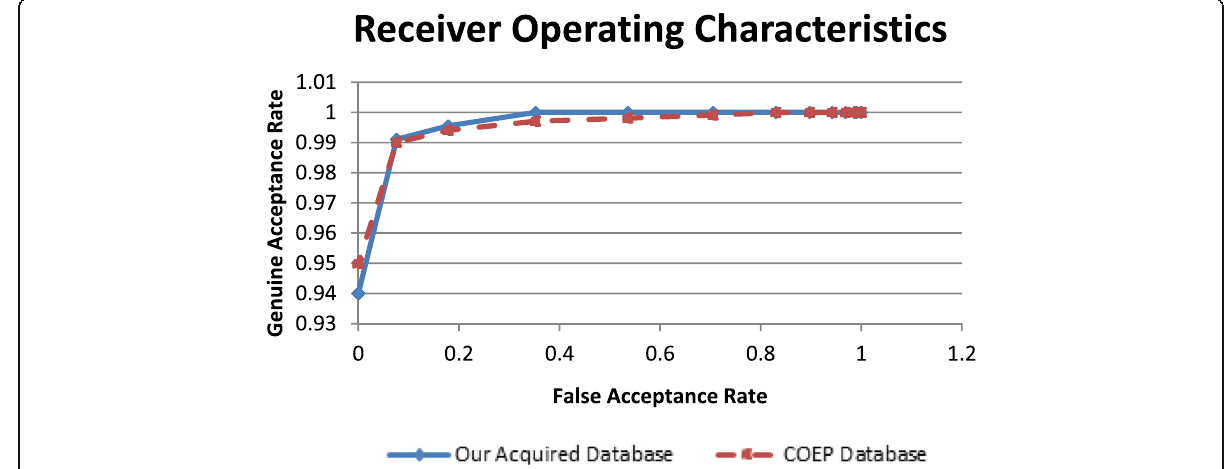
Fig. 9 ROC of palm print modality for both the databases using horizontal coefficients only